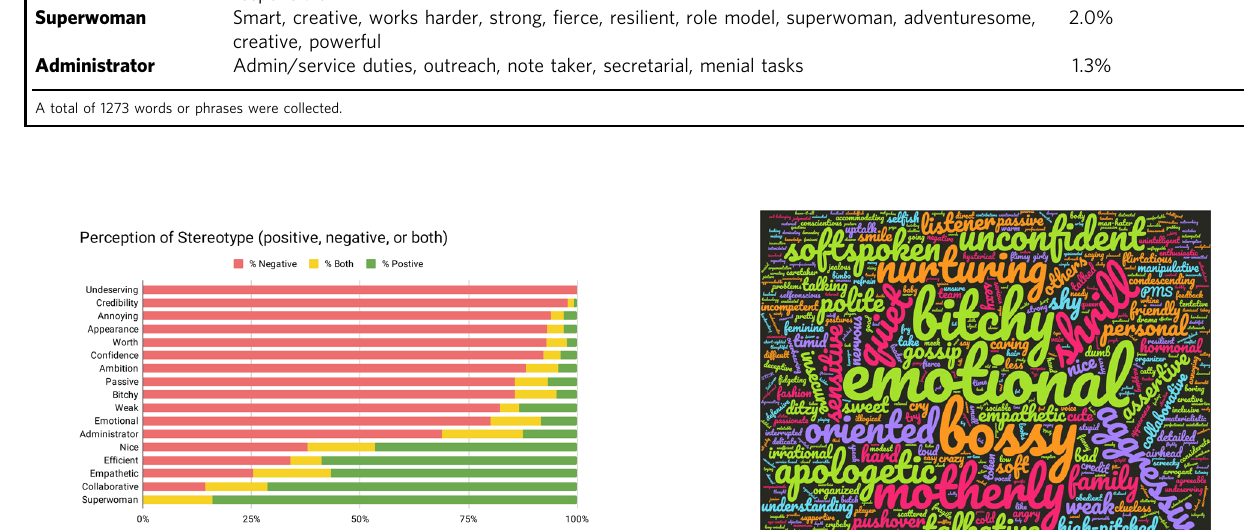
Fig. 1 Perceptions of each stereotype calculated as a percentage of the total responses. Individual focus groups rated each stereotype within the category as either negative, positive or both. Stereotypes are listed from most negatively perceived to least.